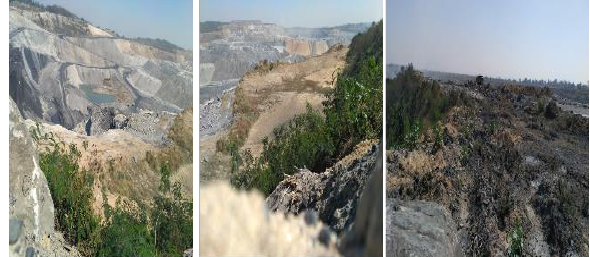
Figure 4 Ground photographs of Kusmunda mine area